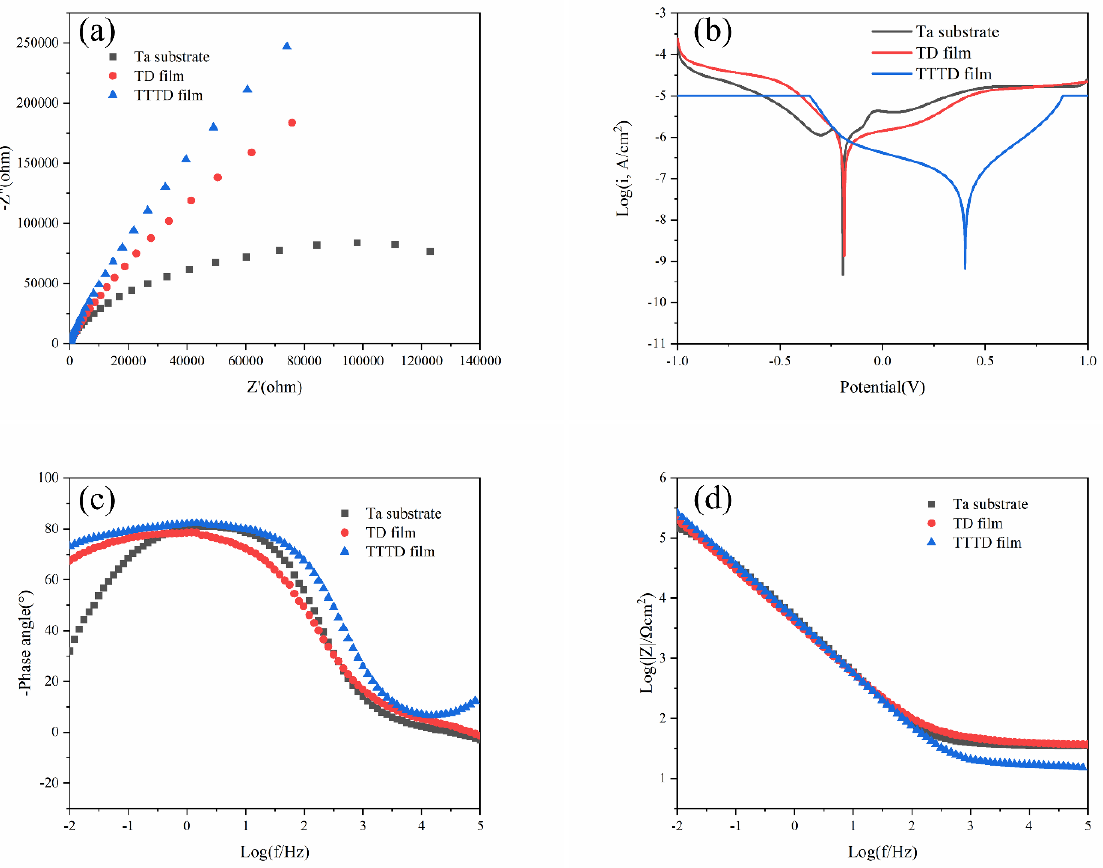
Figure 8. Corrosion test of Ta substrate, TD film and TTTD film in weak alkaline environment: ( a ) Nyquist curve, ( b ) polarization curve, ( c ) phase angle diagram, ( d ) impedance value. Table 1. Corrosion current density and corrosion potential of substrate, TD and TTTD films in weak alkali environment.